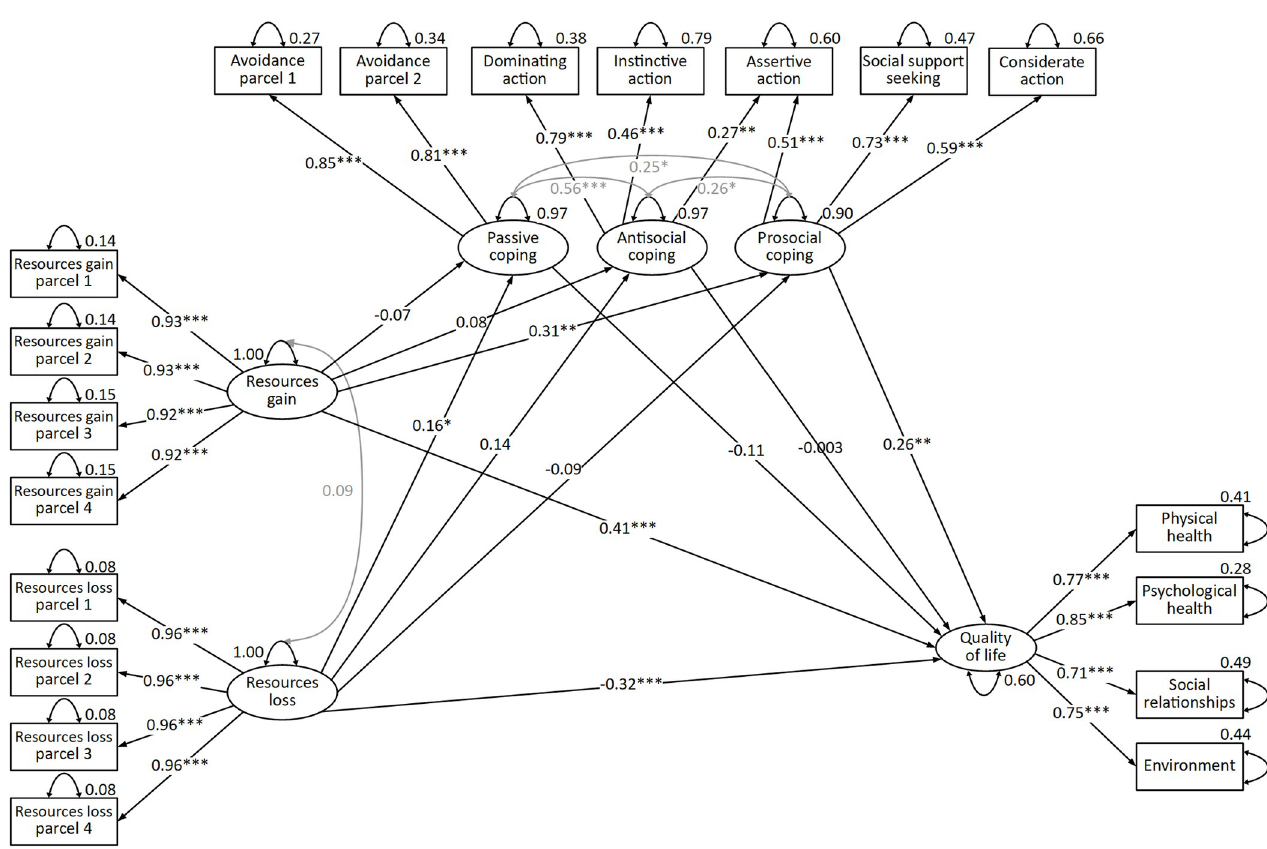
Fig 1. Structural equation mediation model of resources gain and loss, coping, and quality of life ( N = 1037). � p < .05, �� p < .01, ��� p < .001.